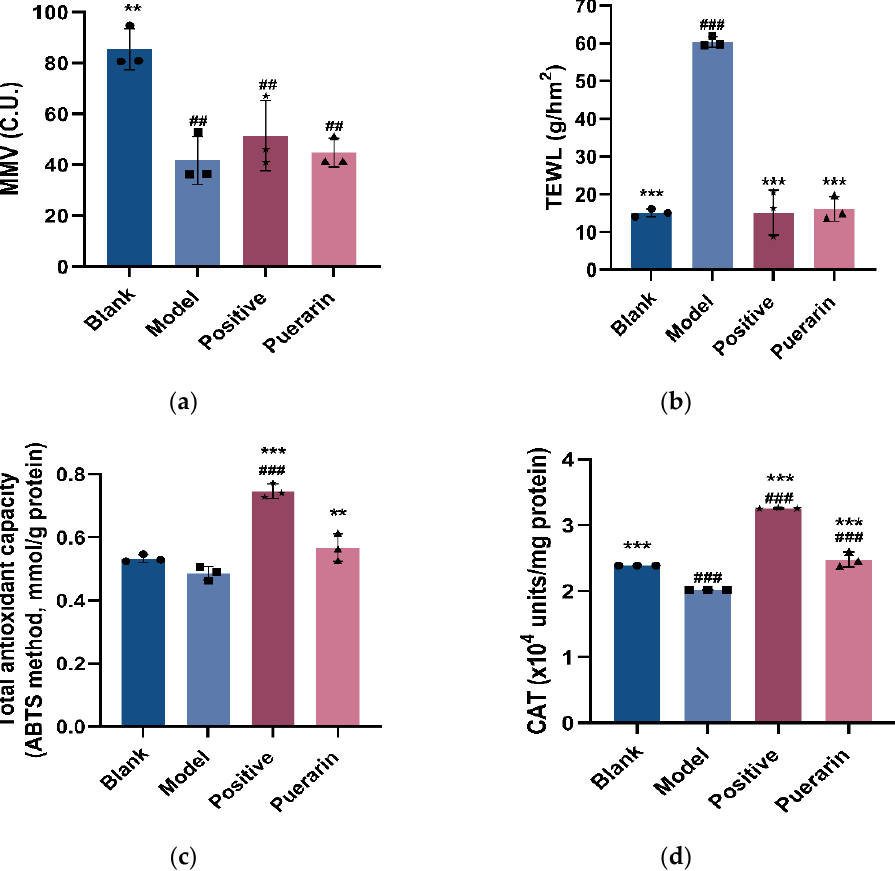
Figure 7. Effects of puerarin on UVA irradiation in mouse skin: ( a ) Results of moisture content (MMV) measurement value in mice skin; ( b ) Results of transepidermal water loss (TEWL) in mice skin; ( c ) Effects of puerarin on antioxidant capacity in mice after UVA irradiation; ( d ) Effects of puerarin on CAT activity in mice after UVA irradiation. ## p < 0.01, ### p < 0.001 as compared to the control group; ** p < 0.01, *** p < 0.001 as compared to the damage model group; Values do not have a common mark ( # , *) when p > 0.05, ( n = 3).